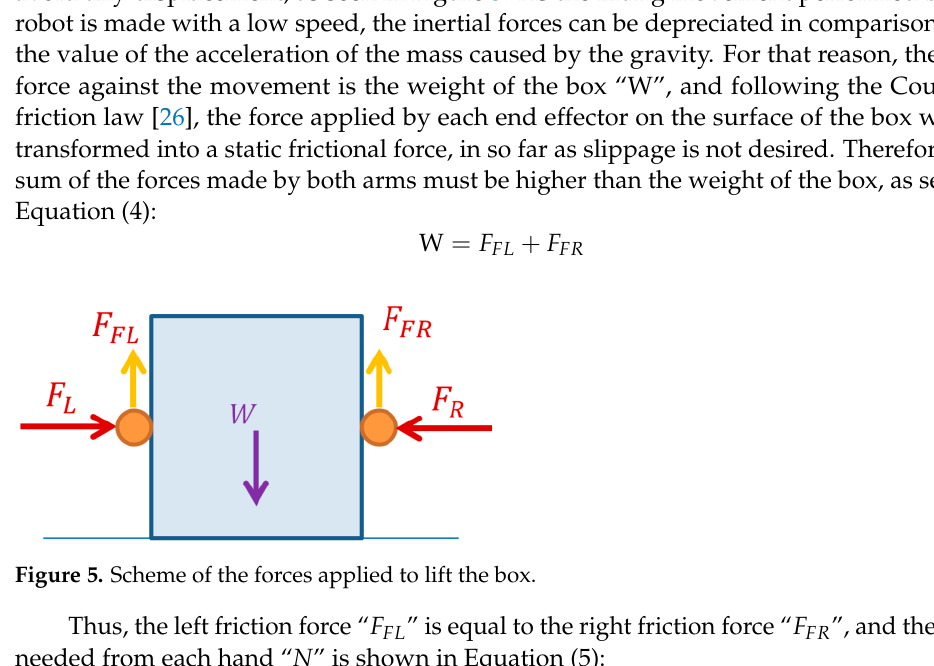
Figure 4. ( a ) Box in the resting position, with the forces represented. ( b ) Box in the equilibrium position, with the weight in the vertical in relation to the rotation axis.